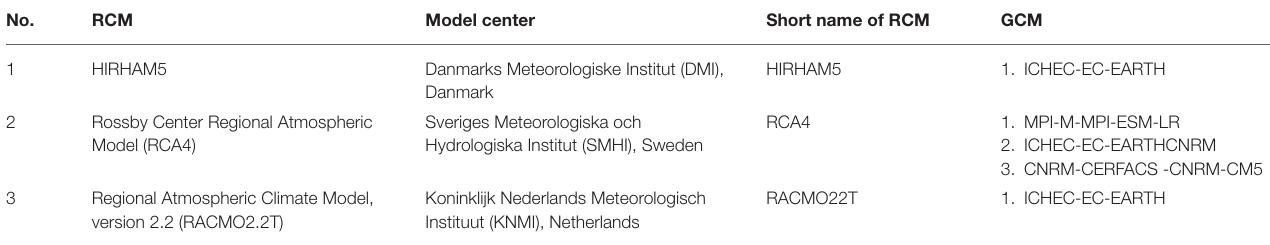
TABLE 1 | The Coordinated Regional Climate Downscaling Experiment (CORDEX)–Regional Climate Models (RCMs) and their driving General Circulation Models (GCMs).